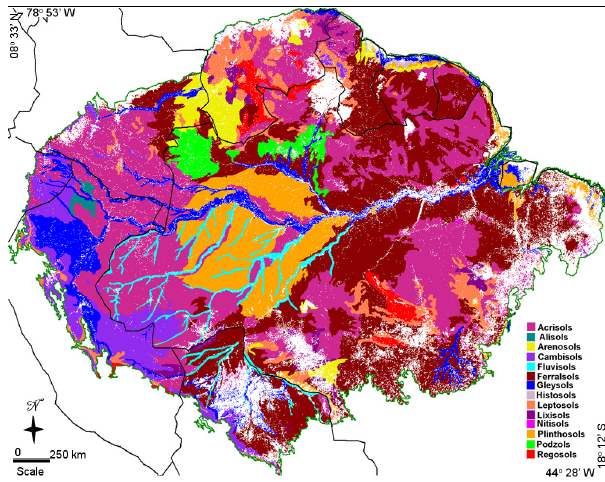
Figure 4. Fig. 4. Basin wide distributions of soils under forest vegeta- tion. Map based on the SOTERLAC–ISRIC soil database (ver- sion 2.0, 1:5million scale) and the vegetation database of Saatchi et al. (2008) for South